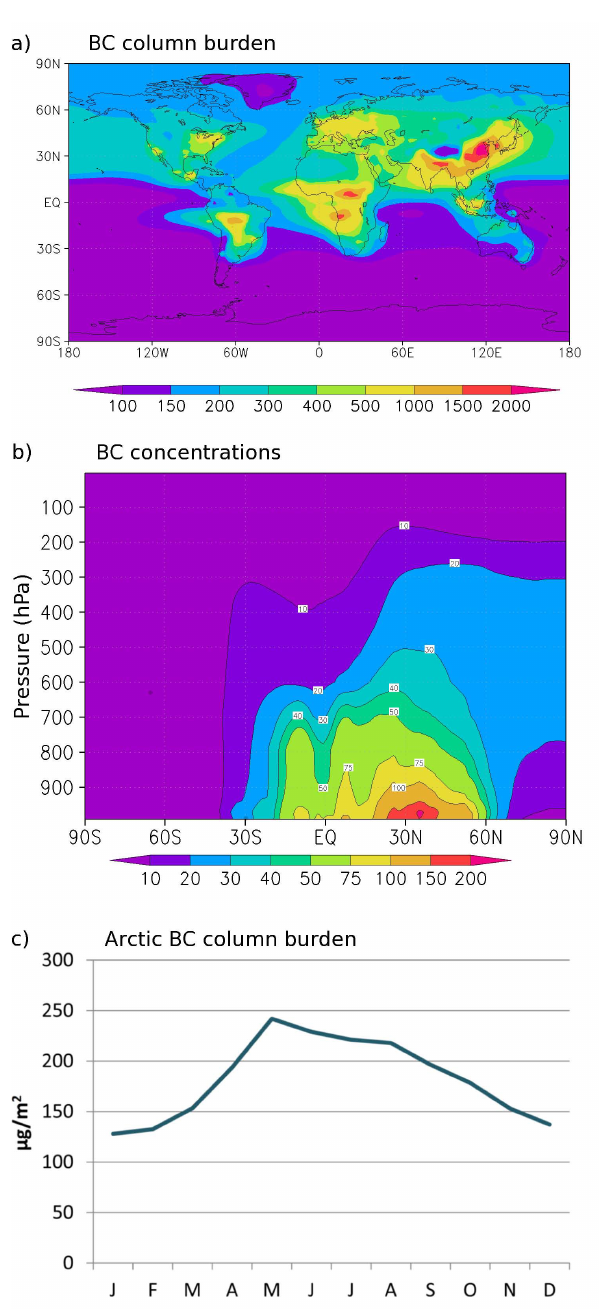
Fig. 1. (a) Annual mean BC column burden (in µgm − 2 ) ; (b) zonal annual mean BC concentration (in ng m − 3 ) and (c) Arctic monthly mean BC column burden (in µgm − 2 ) for the CONTROL run with 2000